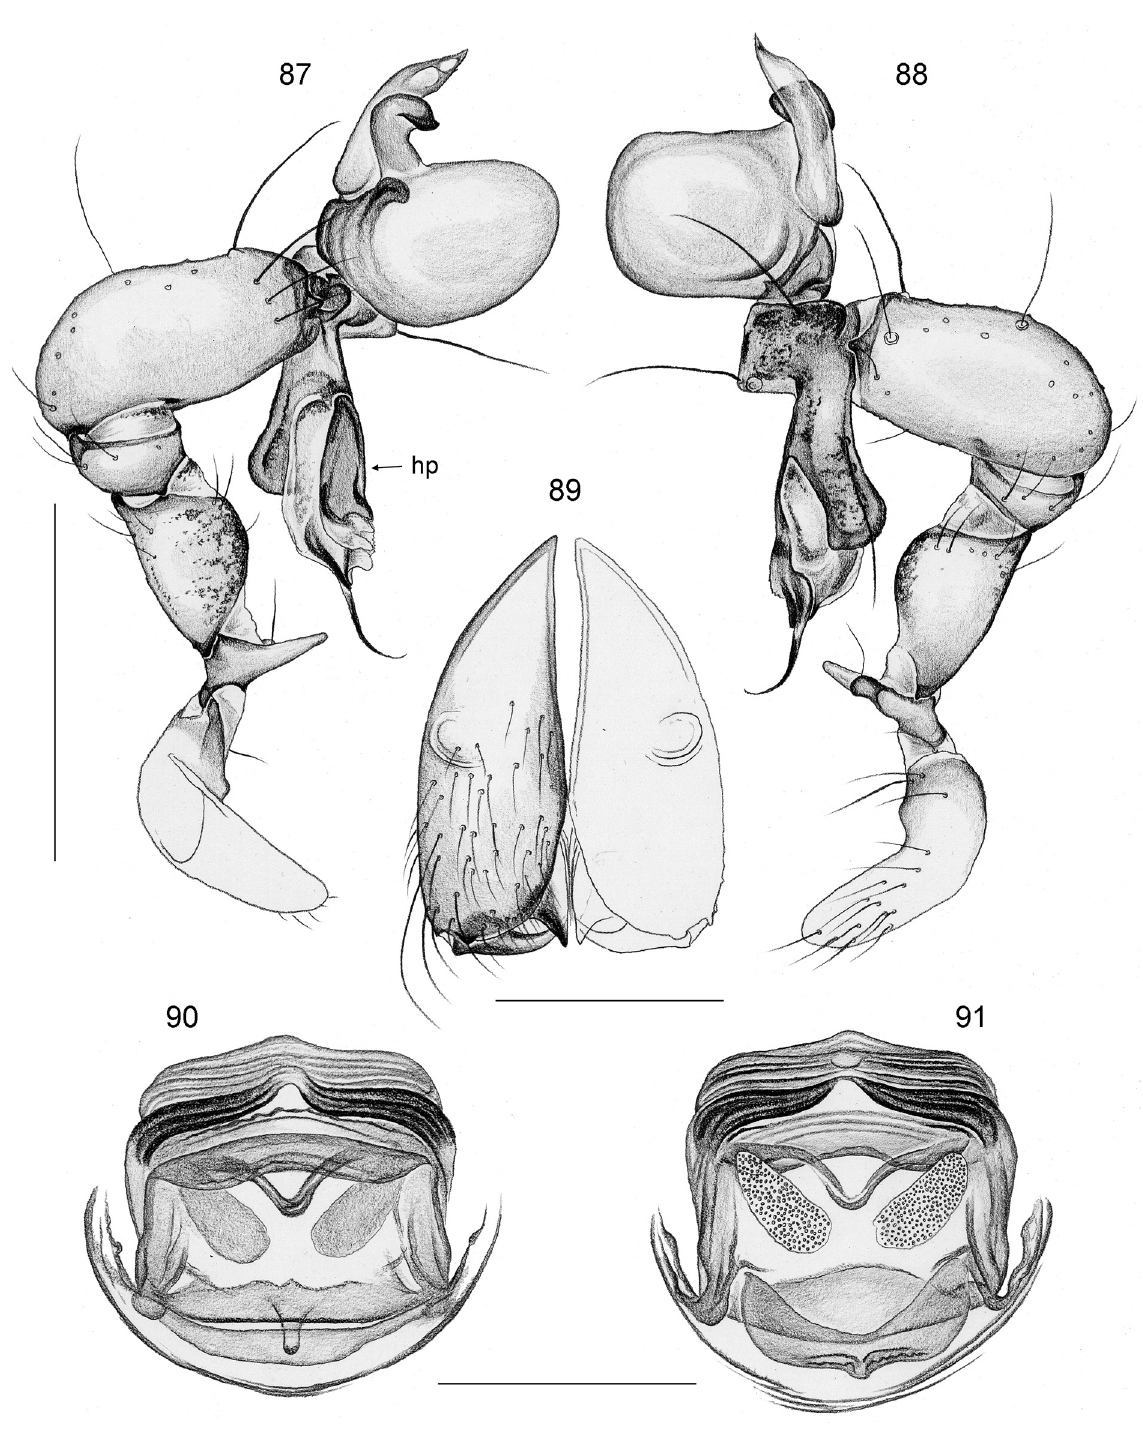
Figs 87-91. Spermophora akwamu sp. nov. 87-88 . Left ♂ palp, prolateral and retrolateral views (hp: hinged process). 89 . ♂ chelicerae, frontal view. 90-91 . Cleared ♀ genitalia, ventral and dorsal views. Scale lines: 87-88 = 0.5 mm; 90-91 = 0.3 mm; 89 = 0.2